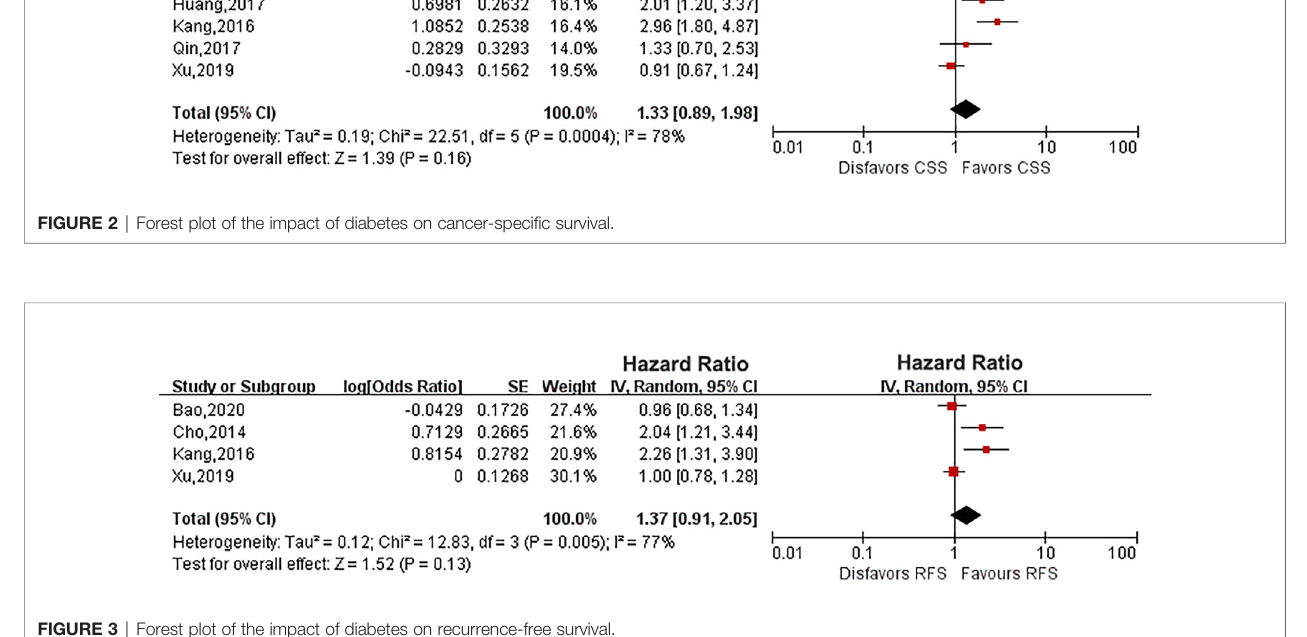
FIGURE 3 | Forest plot of the impact of diabetes on recurrence-free survival.